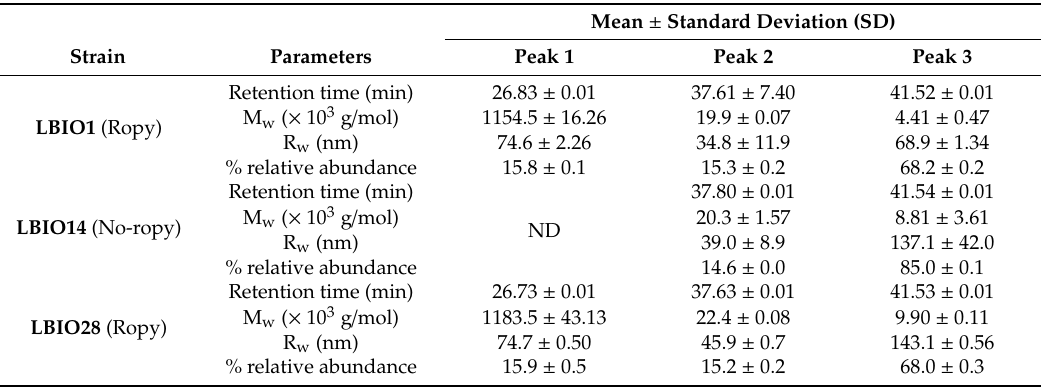
The Supplementary Figure S2 shows the SEC-MALLS (LS detector 90º)